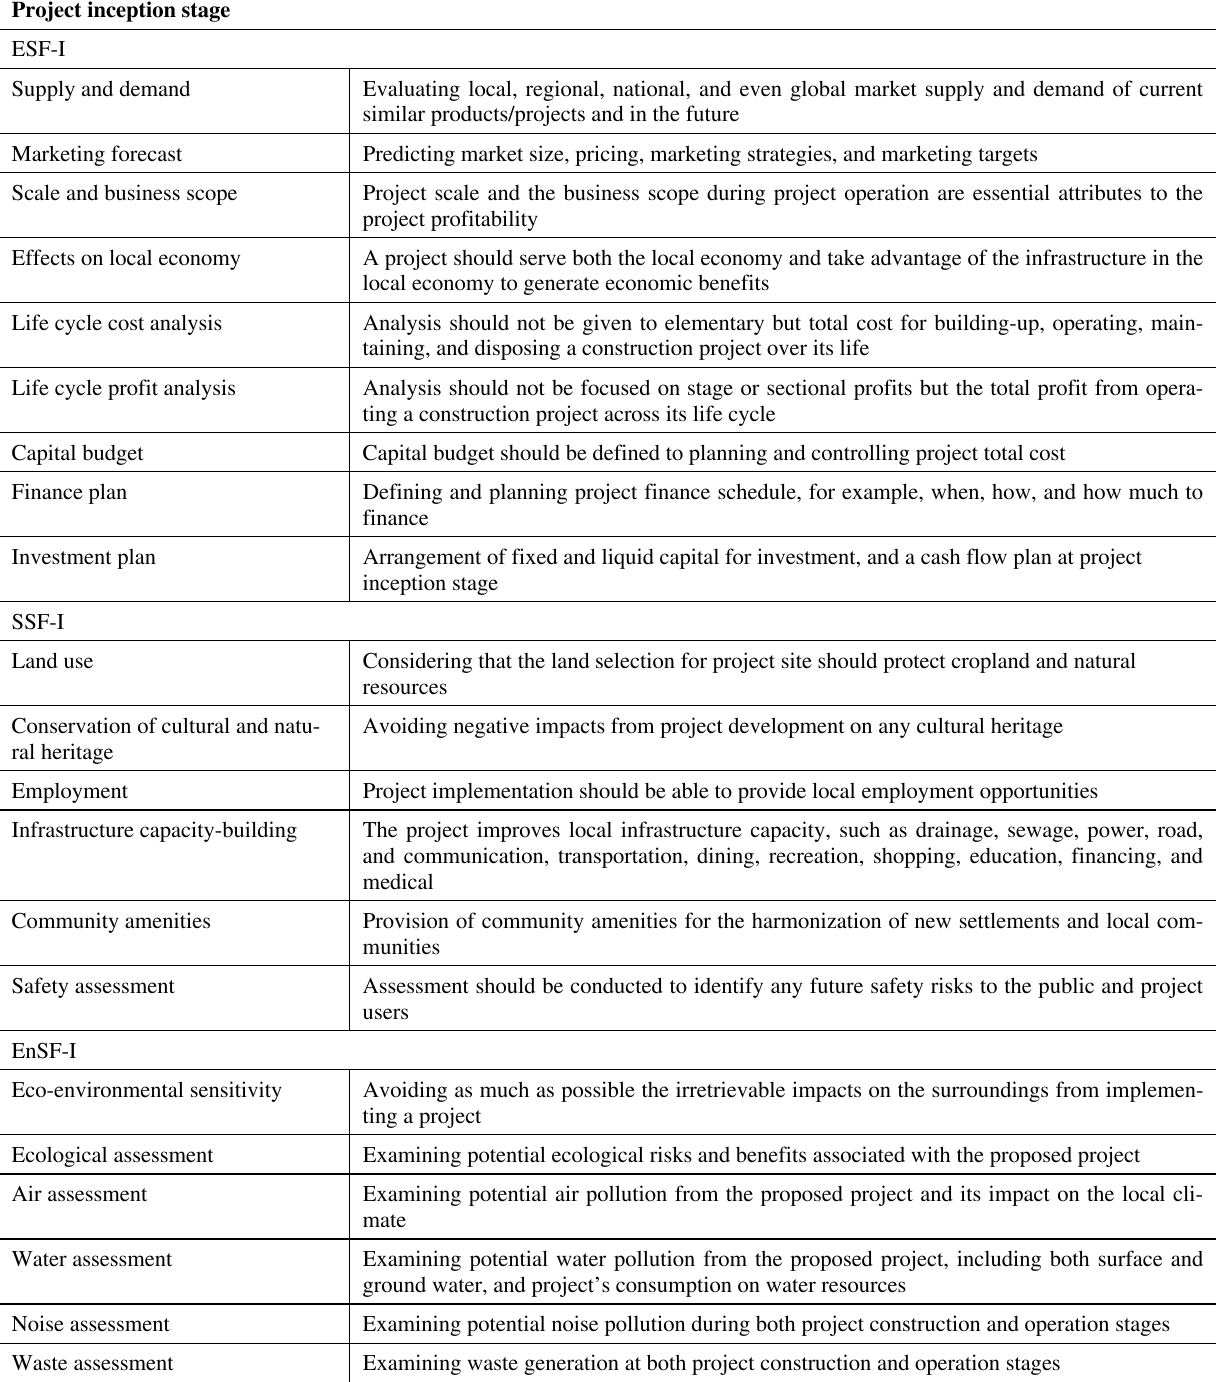
Table 2. Project sustainability performance checklist across project life